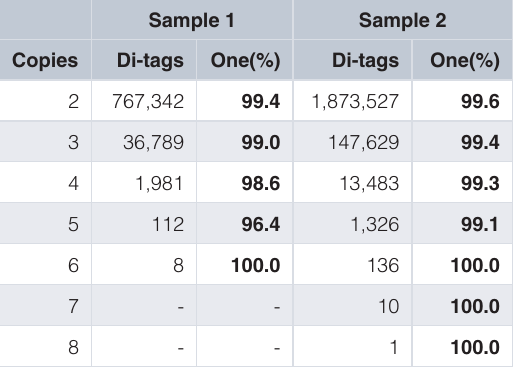
Table 1. Di-tags possessing one barcode combination. The Copies column refers to how many times a di-tag was observed in the dataset, the Di-tags column refers to the number of different di-tags observed with the specified number of copies, and the One column lists the percentage of di-tags in which all the copies possessed identical barcodes.